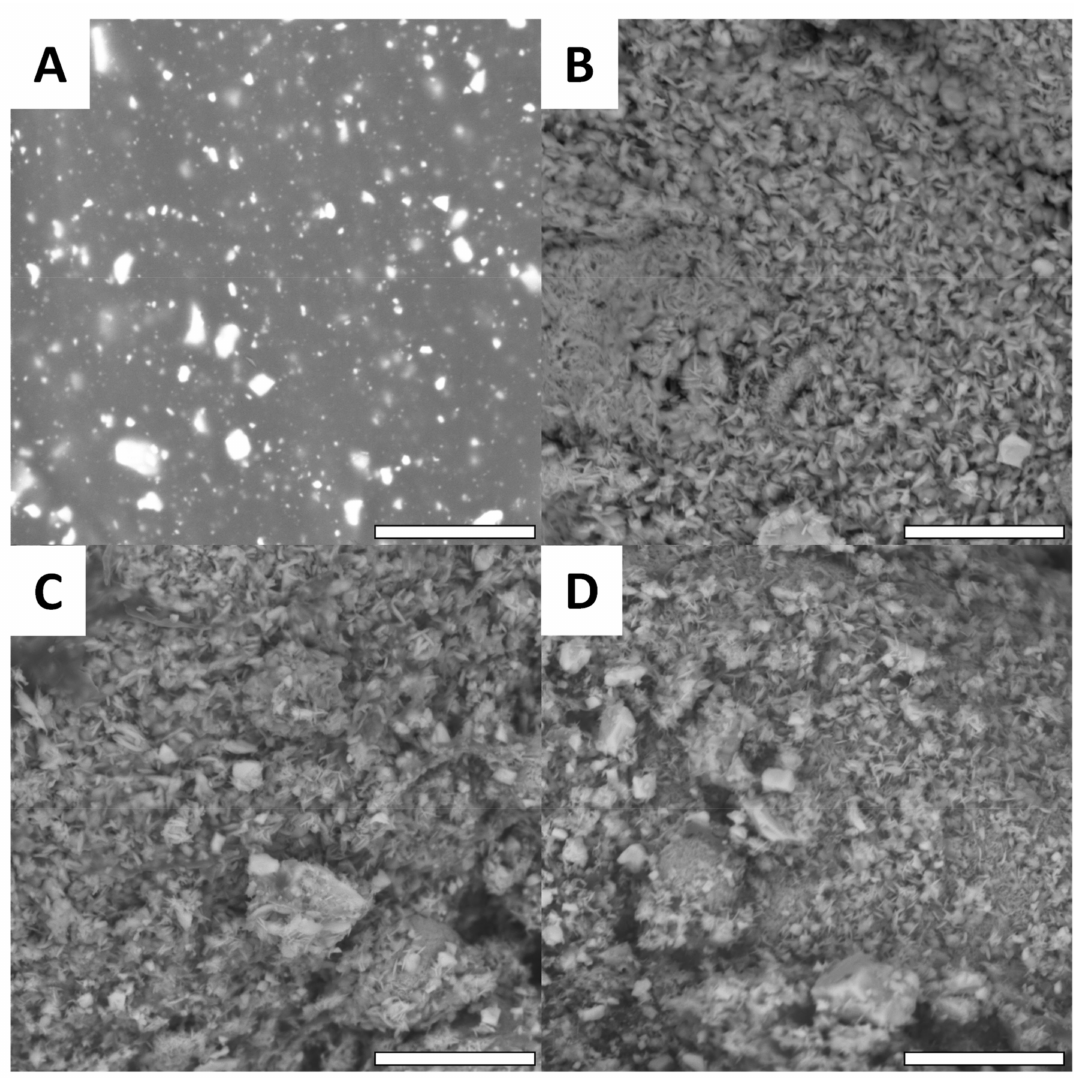
Figure 7. Examples of SEM images with high magnification (scale bar = 8 µ m). The presented surfaces are LMG surfaces, ( A ) Cu, ( B ) Cu(OH) 2 , ( C ) Methoxy and ( D )